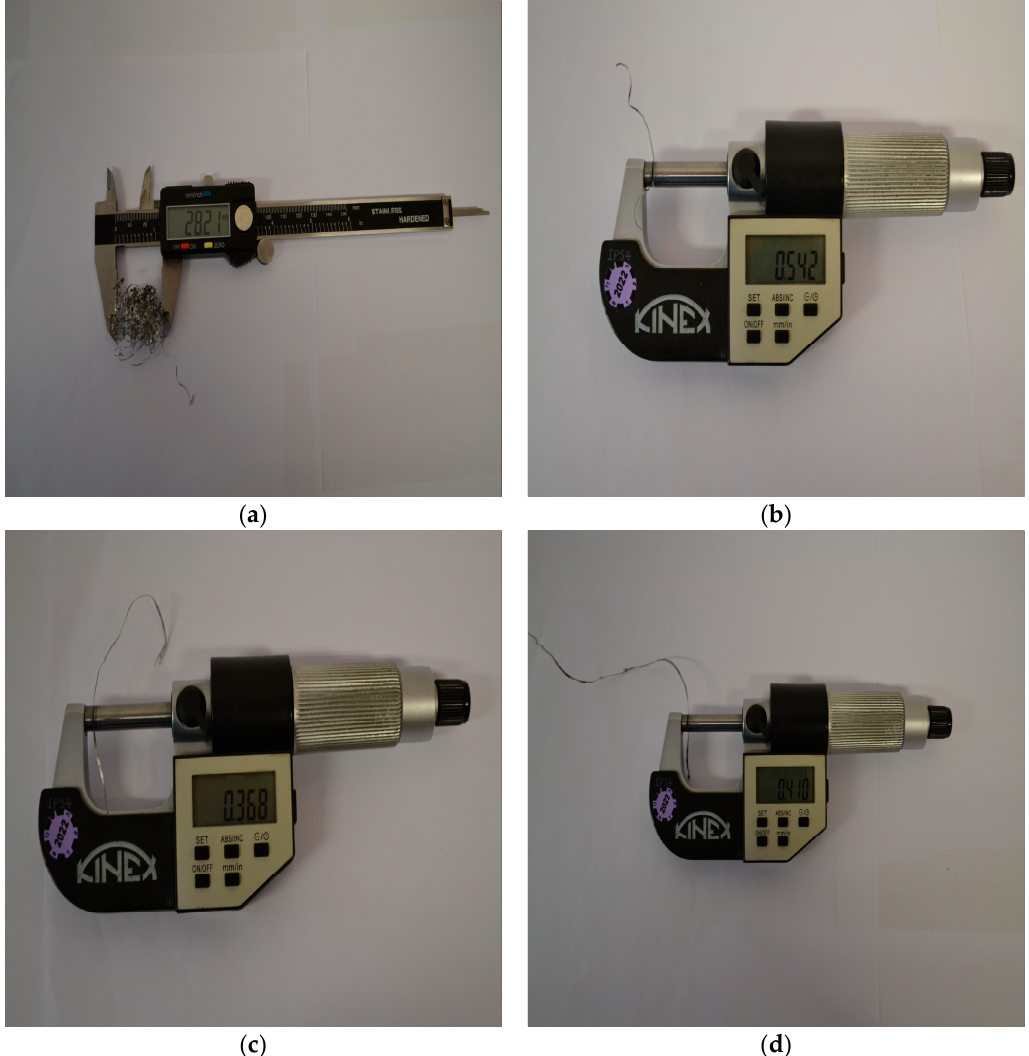
Figure 12. ( a ) Sample of the resulting chip from turning process of AW 5083; ( b ) Chip width measurement in (mm); ( c ) Chip thickness measurement; ( d ) Another sample of chip width measurement. Table 7. The deviation sequence.